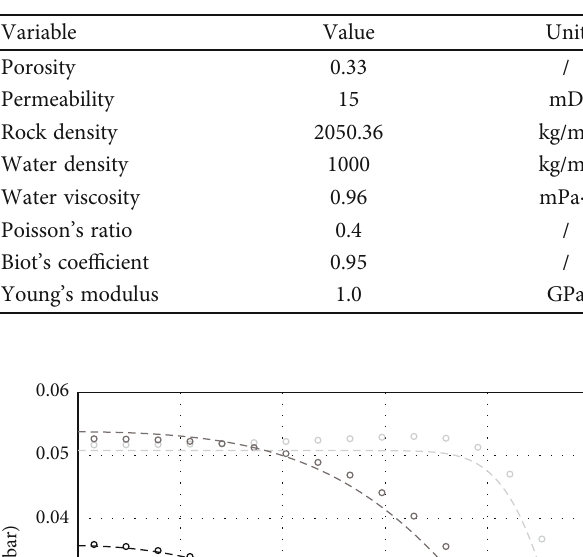
Figure 1: Illustration of Mandel ’ s problem. Table 1: Parameters for Case 2.